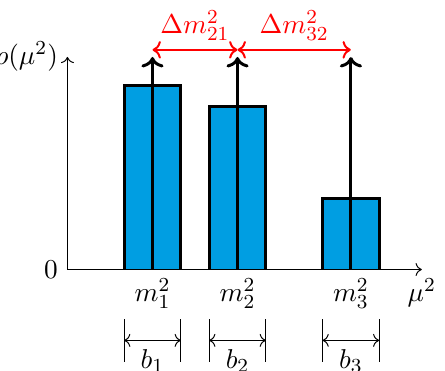
Figure 3. Sketch of the form of the top-hat ρ s ( µ 2 ) for 3 flavour oscillations as defined in eq. 2.21. The bold arrows represent the δ -function eigenstates of the standard